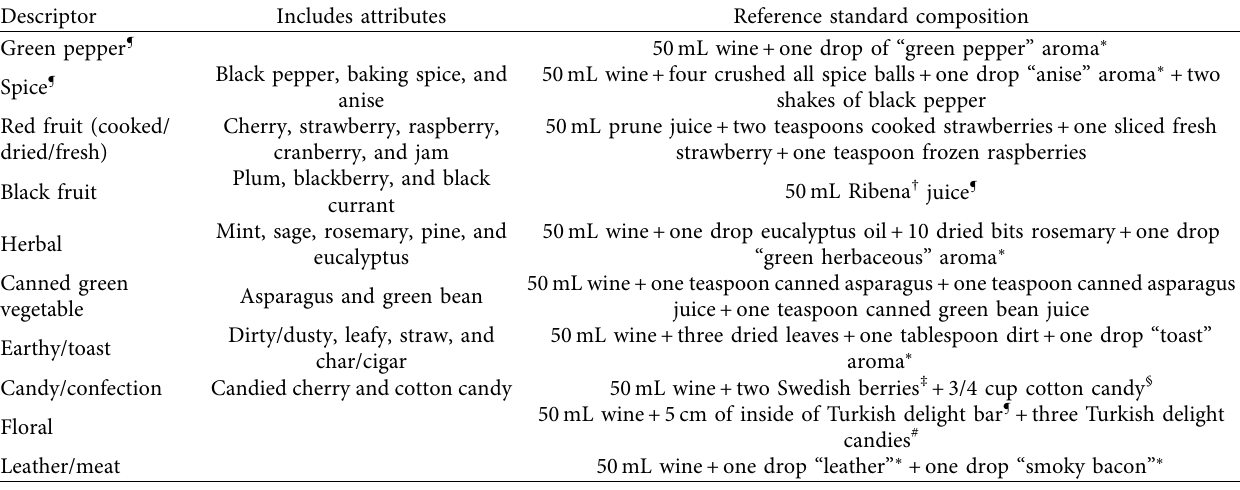
Table 1: Reference standards and descriptors used for sensory analysis of wines made from partially dehydrated grapes.